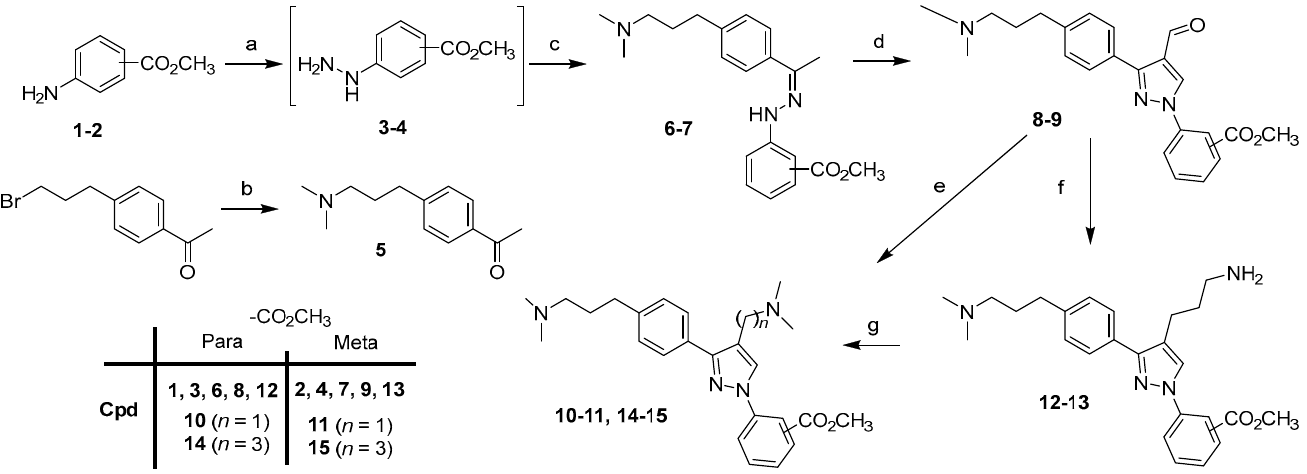
Scheme 1. Synthesis of intermediates 10 – 11 , 14 – 15 . Reagents and conditions: ( a ) i: NaNO 2 , 37%